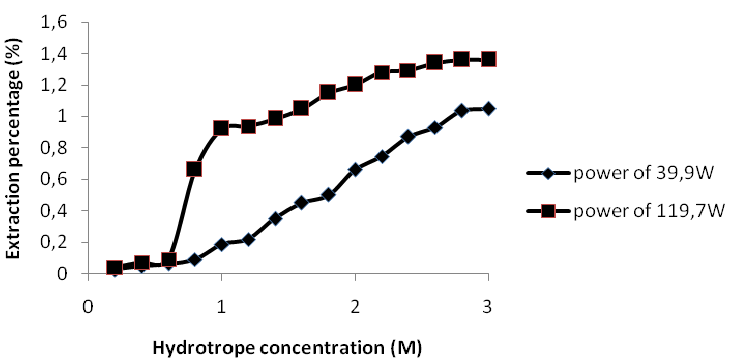
Figure 3. The effect of urea concentration toward the percentage of andrographolide